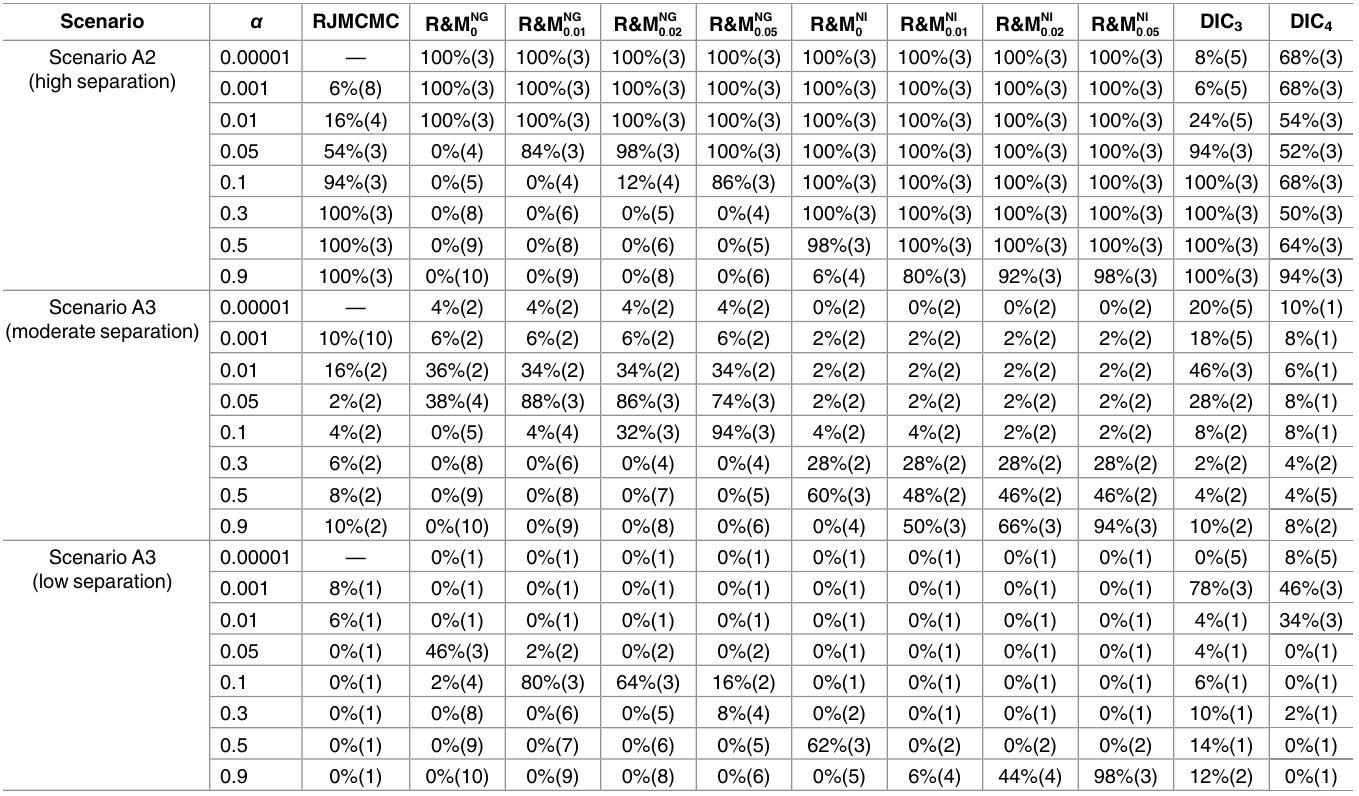
Table 2. The results of Scenario A2–A4. Percentageof data sets in which the true number of clusters was found, with the mode of the estimated number of classes in parentheses. Scenario Scenario A2 (high separation)